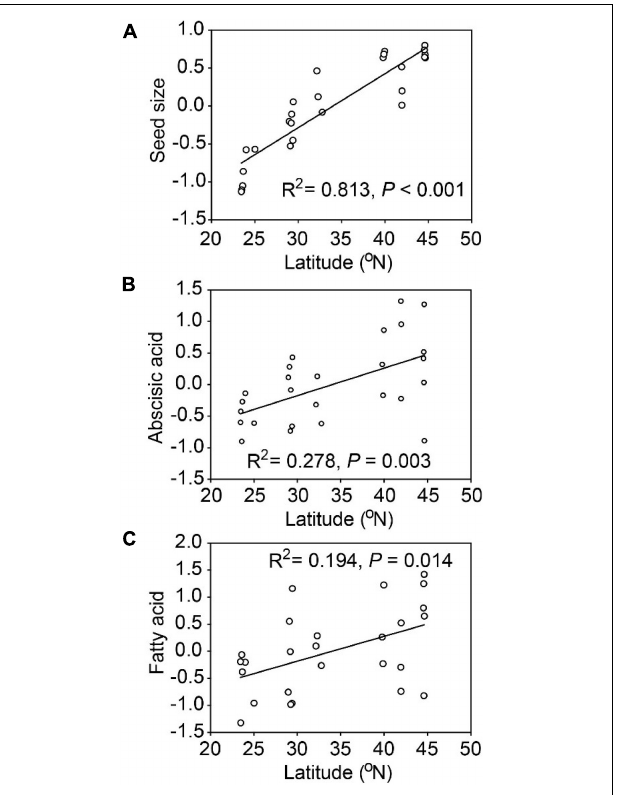
FIGURE 3 | Relationships between latitude and representative variables (PCA axes) for Ambrosia artemisiifolia . The representative variables included seed size (A) , abscisic acid (B) , fatty acid (C) . Each point represents the mean value of all samples in a population (26